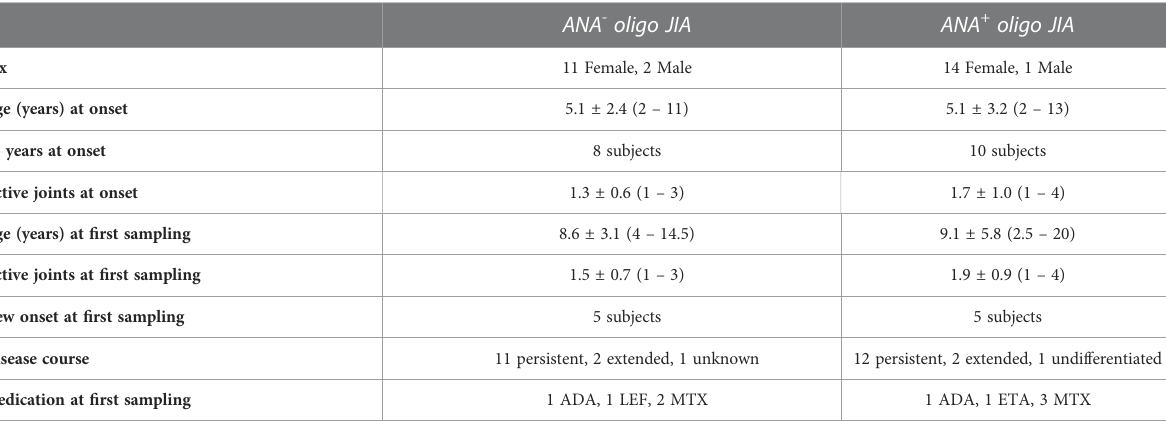
TABLE 1 Clinical characteristics of study